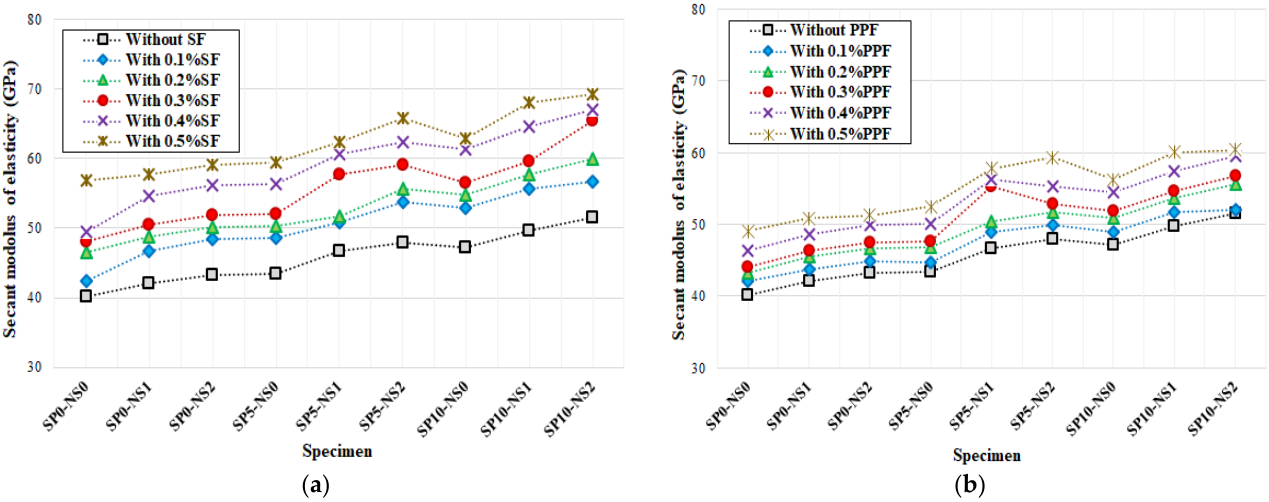
Figure 15. Effect of fibre on the secant modulus of elasticity of HSC containing NS and SP ( a ) SF and ( b ) PPF.